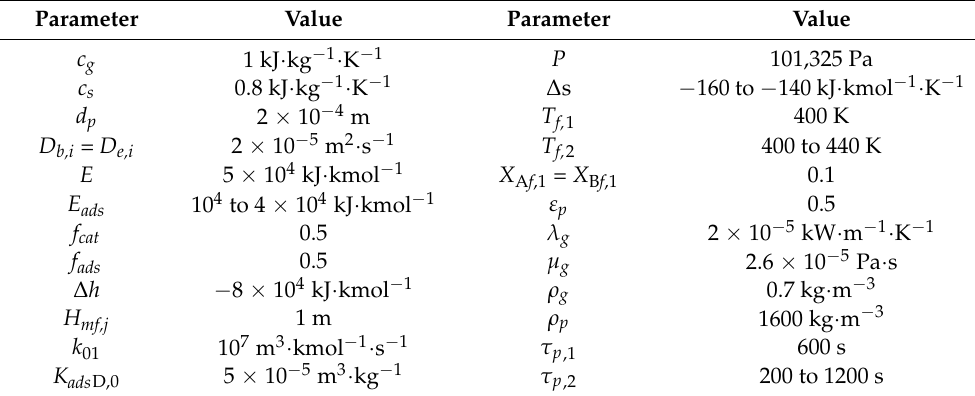
Table 1. Values of the parameters used in the numerical